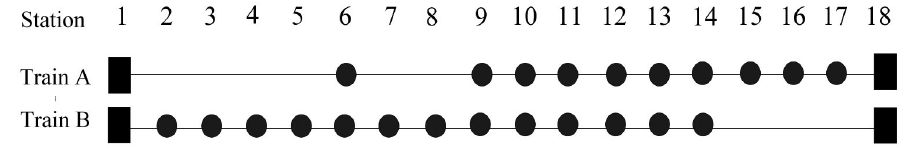
Figure 3. Train Stop Schedule for case